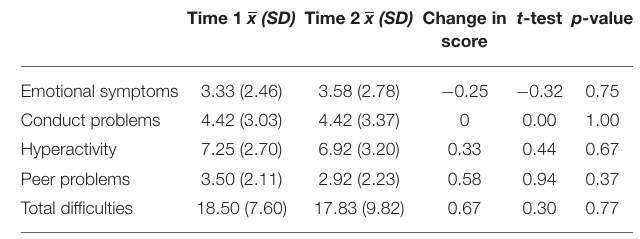
TABLE 6 | Change over time SDQ completed by matched pairs—parents ( n = 5).